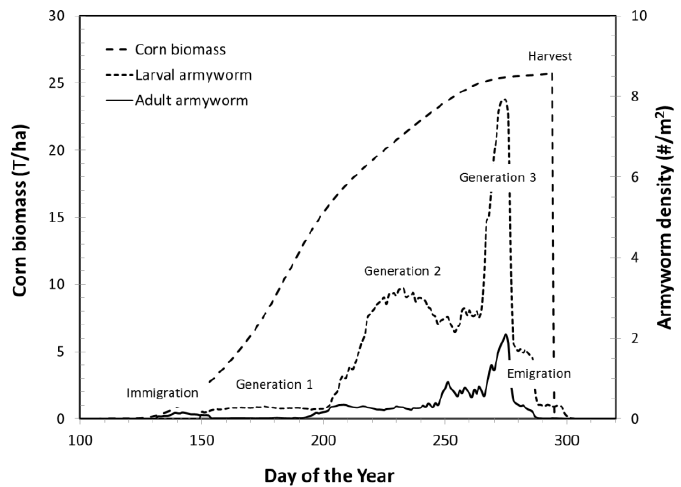
Figure 1. In a typical model run, the crop biomass increased during the spring and summer and was harvested in September or October; crop biomass is shown without crop loss to pests. This simulation is of armyworm on corn in Wayne County, Ohio in 2011. Armyworm adults immigrated in May, and developed three generations before adults entered reproductive diapause in August and emigrated. Yield loss was calculated at harvest based on the magnitude and timing of the larval population density.